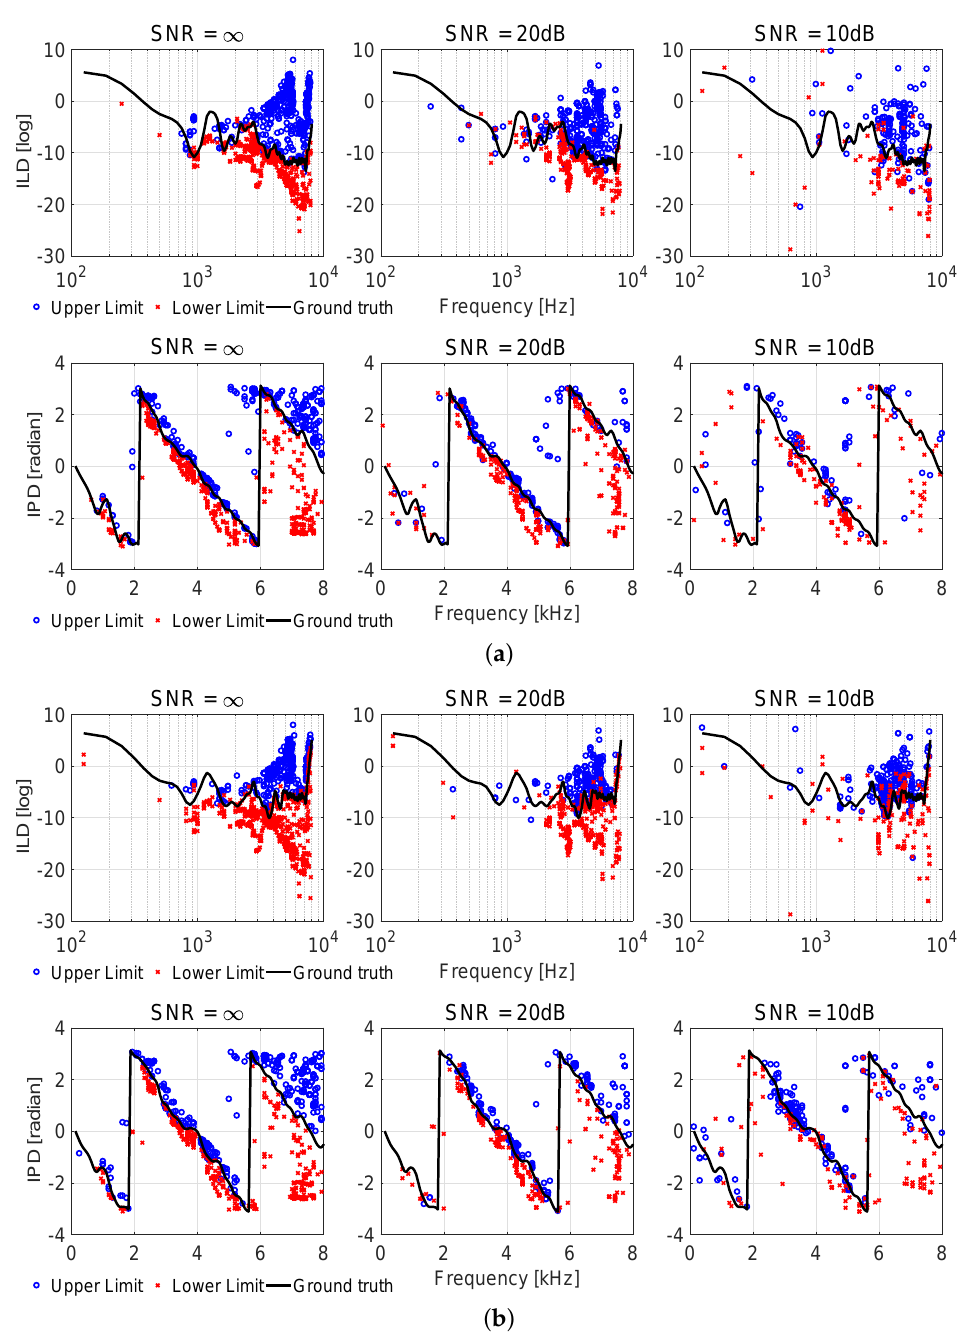
Figure 5. ( a ) Split feature learning for θ = 30 ◦ and φ = 45 ◦ ; ( b ) Split feature learning for θ = 30 ◦ and φ = 135 ◦ . Split feature value comparison between ( a ) θ = 30 ◦ , φ = 45 ◦ and ( b ) θ = 30 ◦ , φ = 135 ◦